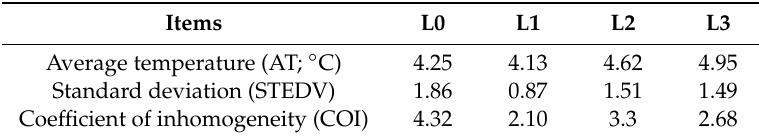
Figure 11. Temperature distribution with different fan locations: ( a ) L0; ( b ) L1; ( c ) L2; and ( d ) L3. Table 4. Analysis results of different parameters.